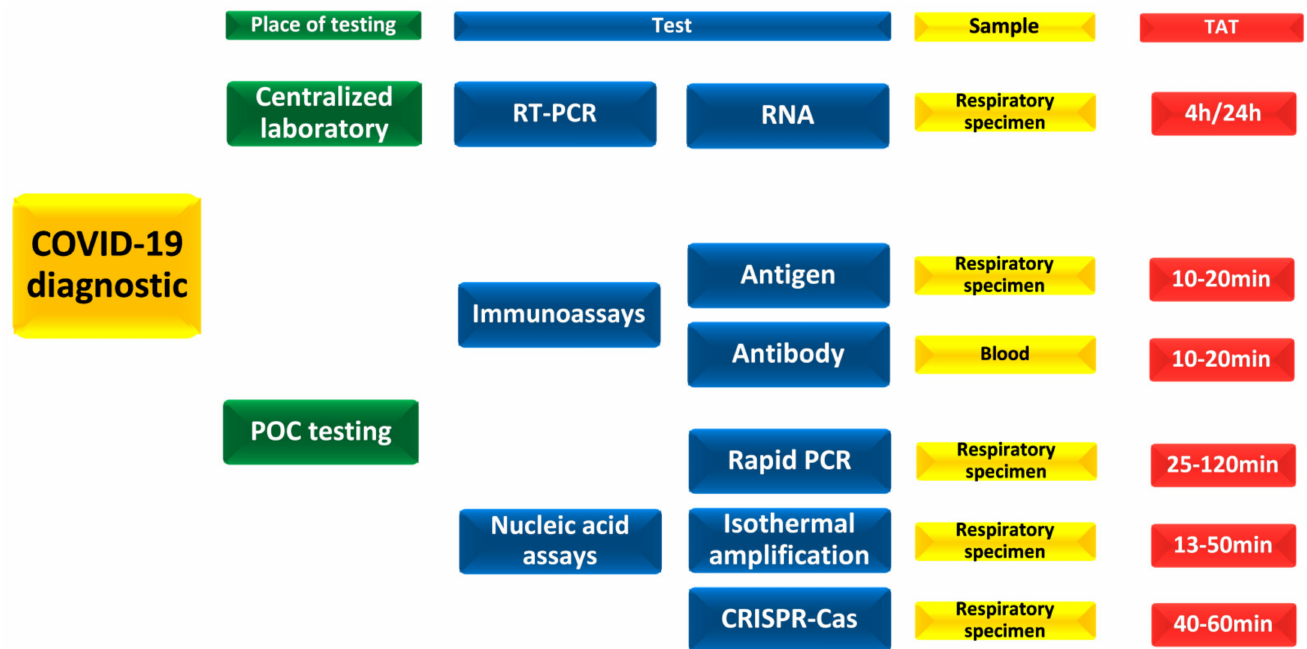
Figure 2. COVID-19 diagnostic possibilities, sampling and turnaround time [184,185]. POC-point of care, TAT–turnaround time, RT-PCR-reverse transcription polymerase chain reaction, RNA-ribonucleic acid, PCR-polymerase chain reaction, CRISPR-Cas-clustered regularly interspaced short palindromic repeats protein; respiratory specimen (nasopharyngeal and oropharyngeal swabs, saliva, bronchoalveolar lavage, tracheal